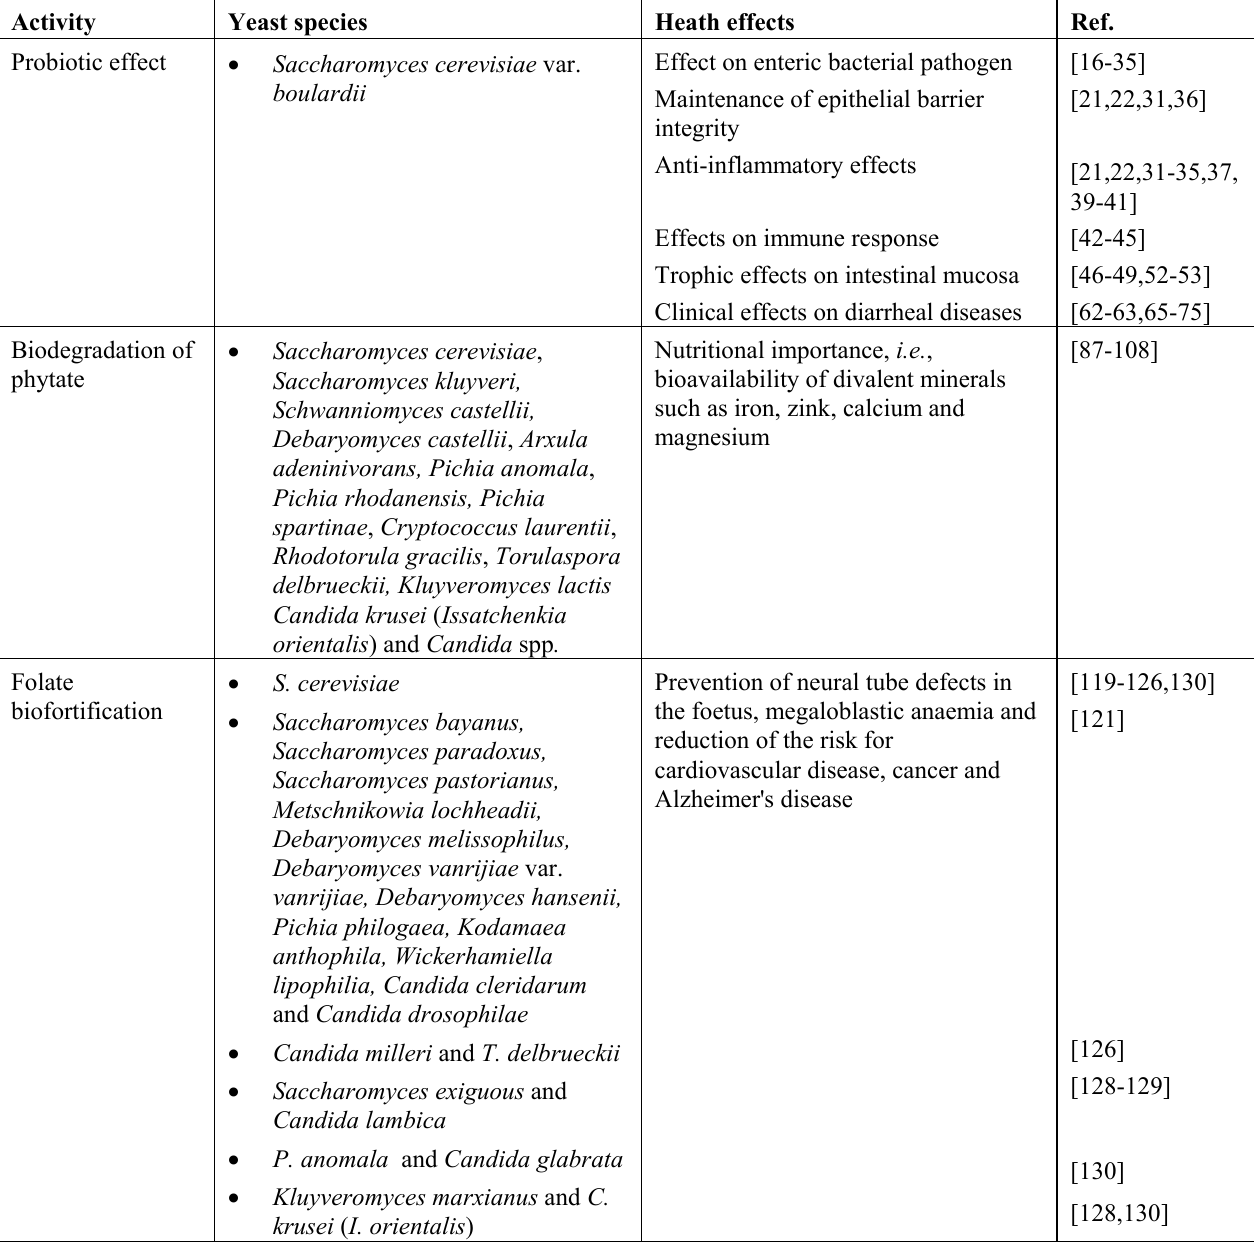
Table 1. Overview of the major beneficial effects of